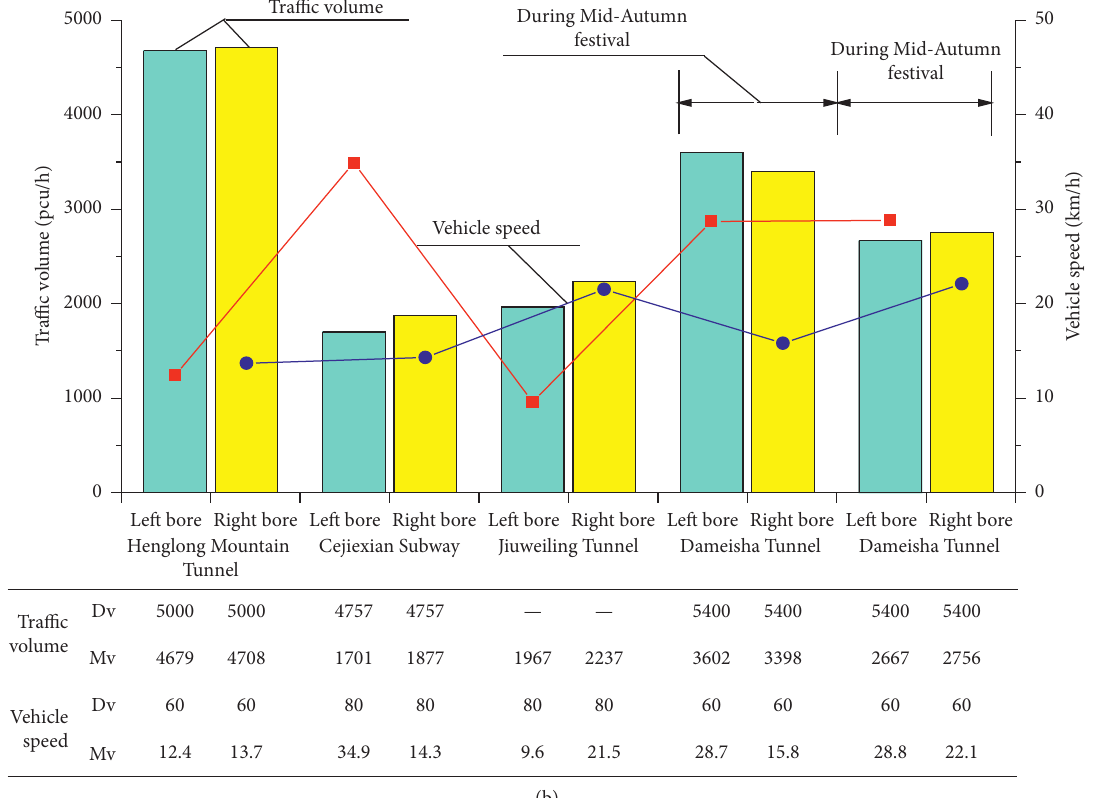
Figure 5: The investigation results of traffic flow. (a) The average daily traffic volume and vehicle speed. (b) The average peak hourly traffic volume and vehicle speed. Note . Dv: designed value; Mv: measured value.